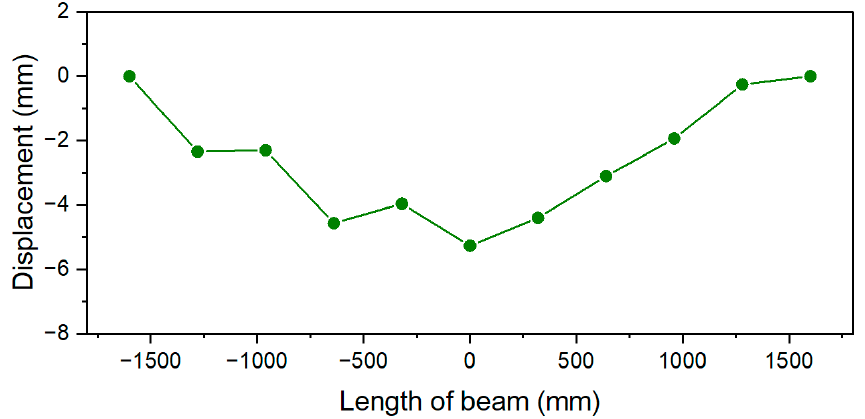
Figure 14. Deflection line created by scanning.